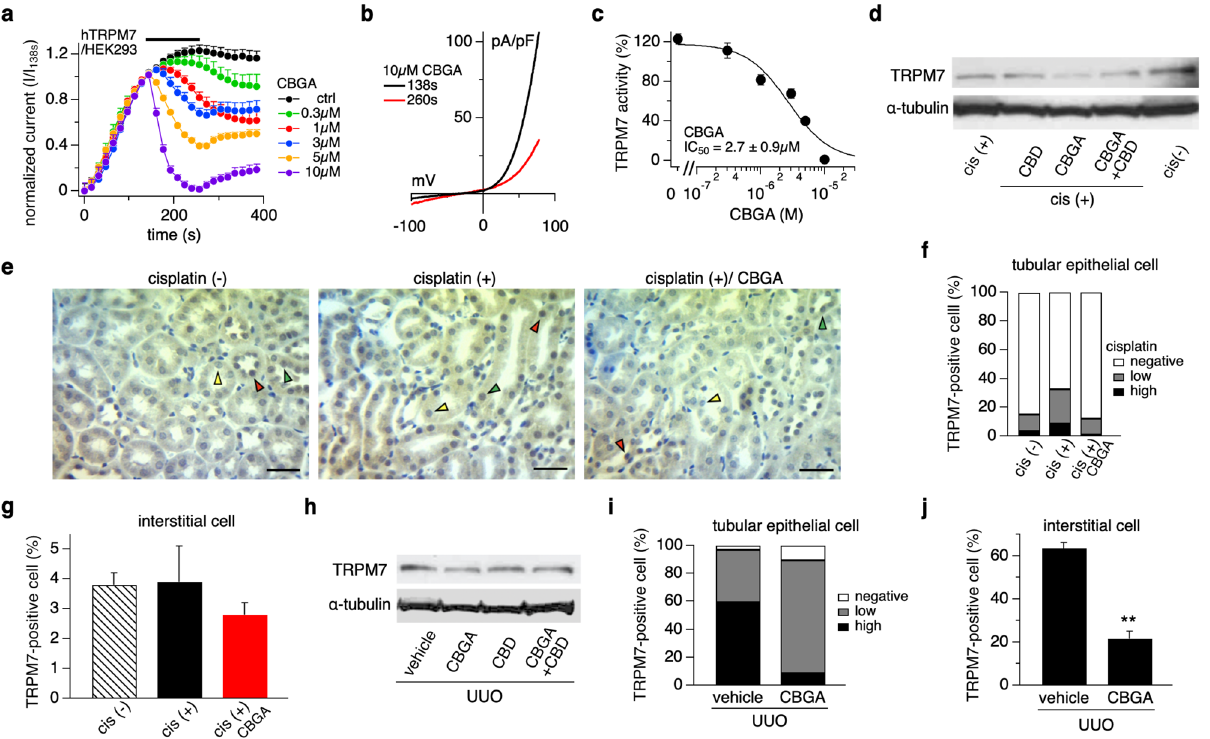
Figure 7. CBGA inhibits TRPM7 currents in HEK293 cells and reduces TRPM7 expression in kidney damage. ( a ) Inhibitory effects of CBGA on TRPM7 currents was investigated by whole-cell patch-clamp recordings from HEK293 cells overexpressing TRPM7. Average TRPM7-mediated outward currents at + 80 mV extracted from ramp currents delivered at 0.5 Hz and plotted as a function of time. Concentrations of 0.3 µM (green circles, n = 5), 1 µM (red circles, n = 7), 3 µM (blue circles, n = 7), 5 µM (orange circles, n = 7), and 10 µM (purple circles, n = 6), were applied from 140 to 260 s (black bar). Standard Ringer without CBGA contained acetonitrile as vehicle and was used as control (black circles, n = 8). ( b ) Average I/V curve of TRPM7 currents extracted before (138 s, black line) and after (260 s, red line) 10 µM CBGA application. ( c ) The dose–response curve of CBGA on TRPM7 channels. Data points for the curve were obtained from the normalized currents in panel ( a ) at 260 s. ( d ) TRPM7 protein expression was examined in kidney tissues from cisplatin-administered mice treated with CBD, CBGA and CBGA + CBD using western blotting (Full images are shown in Supplementary Fig. S5a). ( e ) Representative pictures of immunostaining to TRPM7 (magnification × 400) in kidneys from non-cisplatin treated mice (left panel), cisplatin-treated mice (middle panel) and cisplatin/CBGA-treated mice (right panel). Scale bars represent 50 µm. Green arrow heads indicate TRPM7-low expression and red arrow heads are high expression levels of TRPM7, yellow arrow heads indicate TRPM7-negative (TRPM7 staining not detectable) in renal tubular epithelial cells. ( f ) The percentage of TRPM7-positive cells in tubular epithelial cells in kidneys from cisplatin-treated mice. TRPM7-high expression (black bars), TRPM7-low expression (gray bars) and non- detectable TRPM7 staining (white bars) in tubular epithelial cells assessed in a total of 10 non-overlapping fields. ( g ) The percentage of TRPM7-positive interstitial cells assessed in the same fields as in panel ( f ). ( h ) TRPM7 protein expression was examined in cortical UUO kidney tissue from mice treated with vehicle, CBGA, CBD and CBGA + CBD using western blot (Full images are shown in Supplementary Fig. S6a). ( i ) The percentage of TRPM7 in tubular epithelial cells from UUO kidneys treated with CBGA or not. Same experimental protocol as in ( f ). Representative pictures are shown in Supplementary Fig. S6c. ( j ) The percentage of TRPM7-positive interstitial cells assessed in the same fields as in panel ( i ). **p < 0.01 vs. vehicle treatment remaining 84.9% cells had undetectable TRPM7 staining (Fig. 7f, white bar). In cisplatin-treated mice, TRPM7- positive cells increased in tubular epithelial cells, where 24.1% displayed TRPM7-low expression and 8.7% had highly expressed TRPM7 (Fig. 7f). CBGA treatment of cisplatin-exposed mice reduced TRPM7-high positive tubular epithelial cells to just 1.1% and reduced TRPM7-low cells to 11.3% (Fig. 7f). Similarly, as illustrated in the supplemental data, cisplatin up-regulated TRPM7 mRNA in a cultured epithelial cell line from normal rat kidney (NRK-52E) but not in fibroblasts (NRK-49F, Supplementary Fig. S5c). Conversely, the percentage of